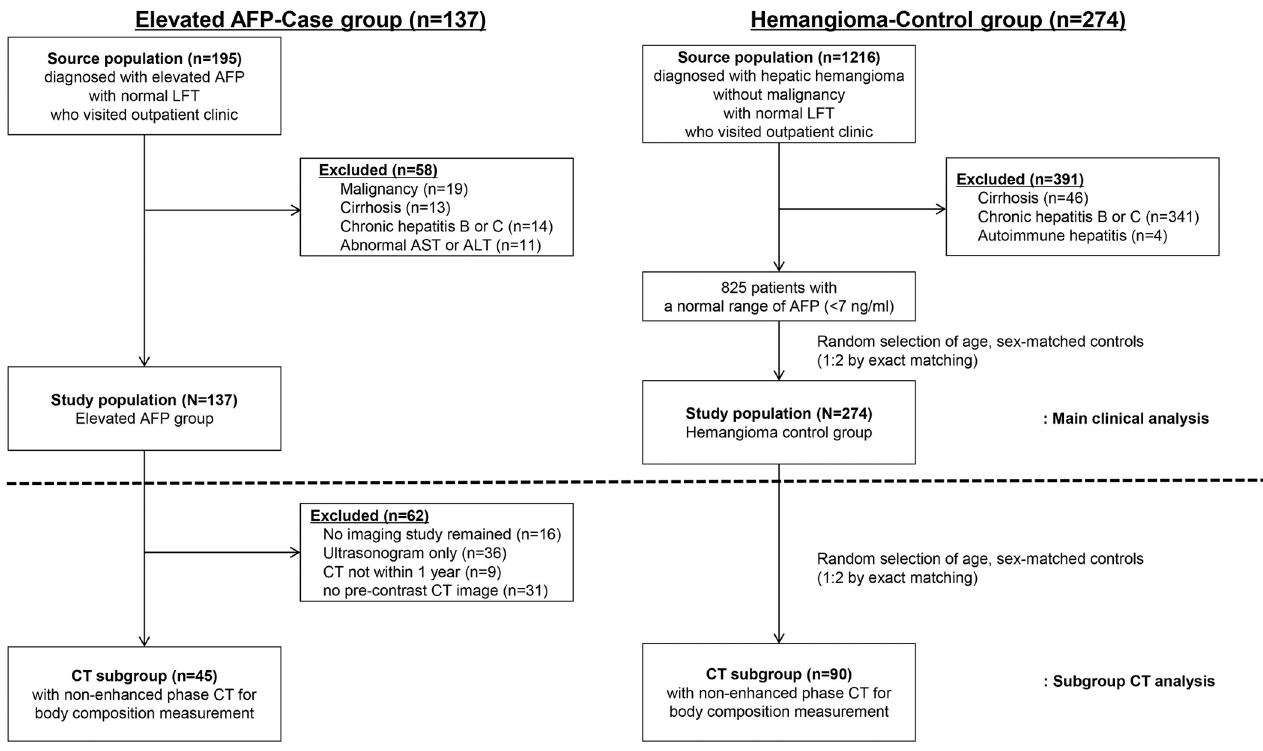
Fig 1. Patient selection flow gram. A total of 137 patients with an elevated AFP level without any malignancy, ovarian teratoma, liver cirrhosis, chronic hepatitis, or elevated serum aspartate aminotransferase or alanine aminotransferase level above the upper normal limit of 40 IU/mL were compared with the hemangioma control group who had normal serum AFP levels. To analyze adiposity, 45 patients with non-enhanced CT images in the elevated AFP level group were compared to 90 patients with non-enhanced CT images in the hemangioma control group.